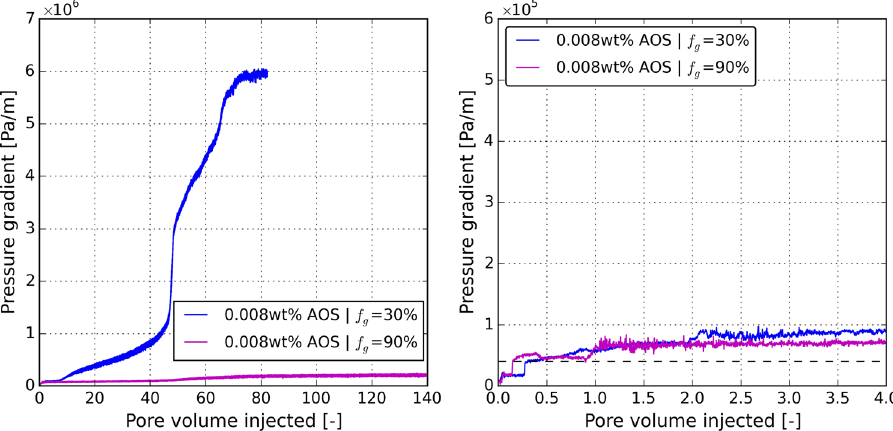
Figure 7. ( a ) The measured pressure history of the first step of the surfactant-concentration experiments, i.e., the lowest surfactant concentration (see Table 2) for different foam qualities. ( b ) Magnification the first four pore volumes of the injection. The horizontal black dashed line in Fig. 7b indicates the critical pressure gradient in which the pressure gradient starts to build